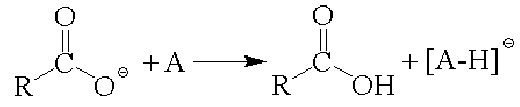
Scheme 2. Proton transfer reaction between ILM and analyte.